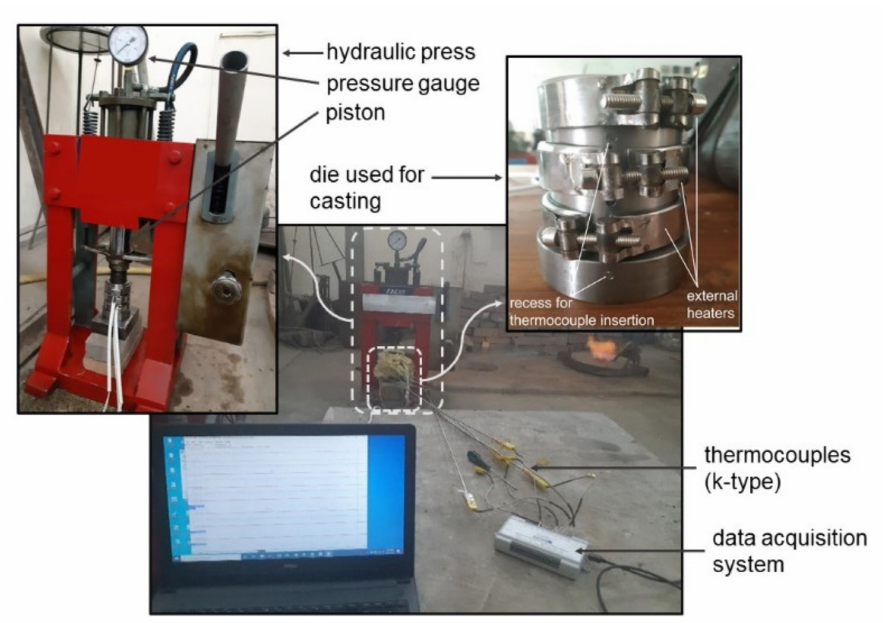
Figure 1. Schematic of the die.